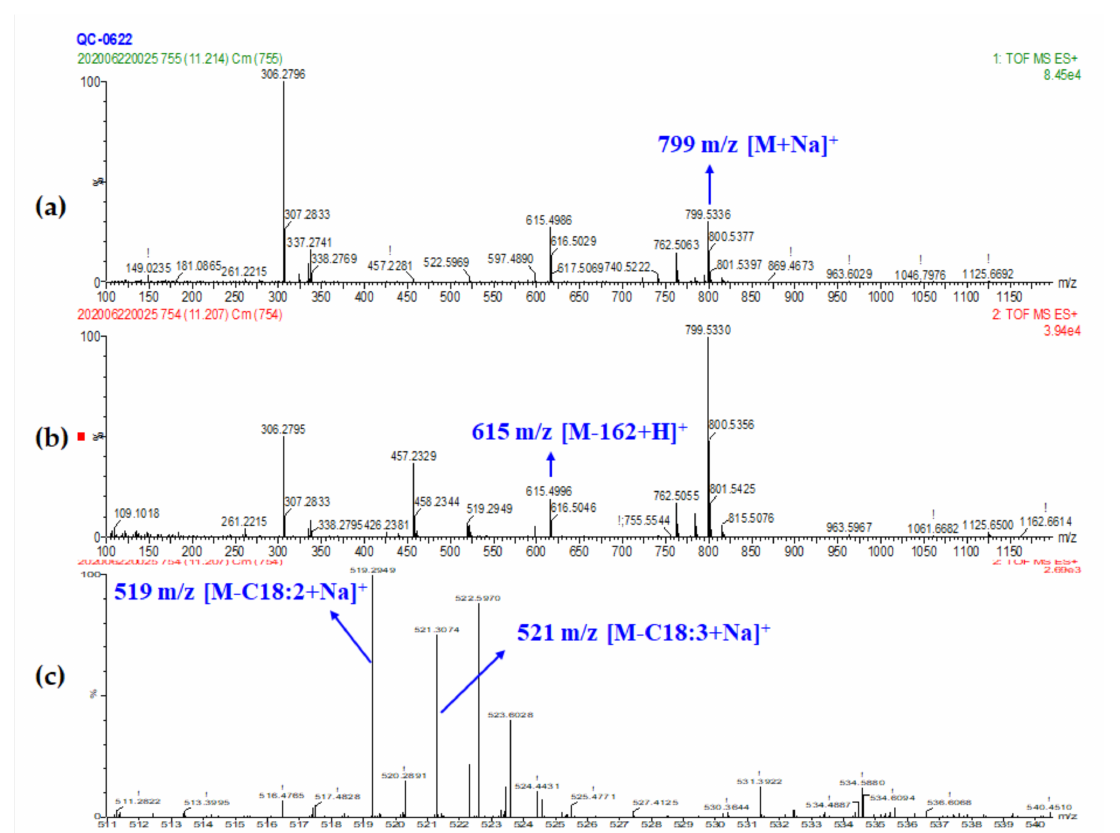
Figure 3. MS spectra of MGDG (18:3/18:2). (peak 14) ( a ) MS 1 spectrum, ( b ) MS 2 spectrum and ( c ) Amplificatory MS 2